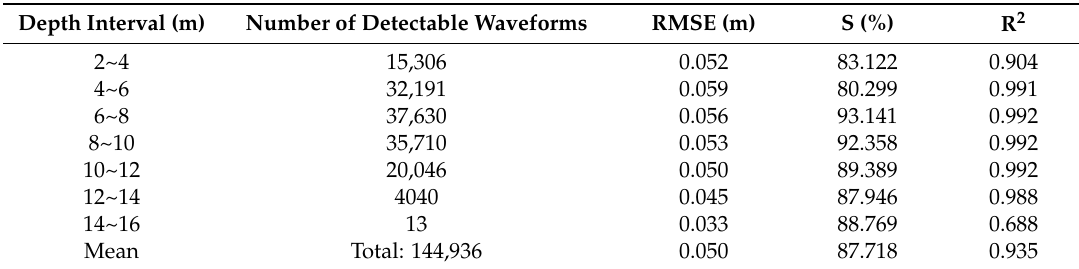
Table 7. Performance of the GHPD method in Experimental area A.